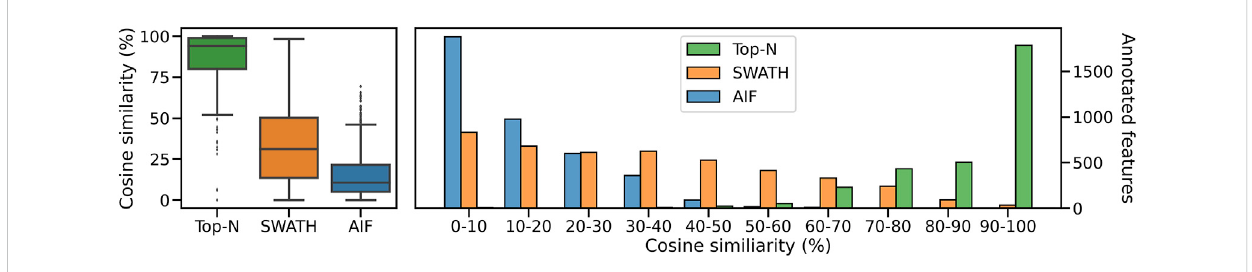
FIGURE 4 The distribution of cosine similarity scores as a boxplot (left) and a histogram (right) when matching observed spectra to the true reference spectra for 5,000 chemicals.